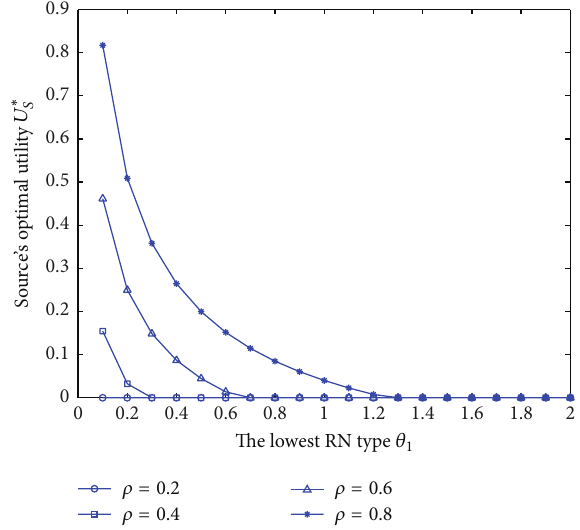
Figure 6: Source’s optimal utility 𝑈 ∗ 𝑆 versus the lowest RN type 𝜃 1 for fixed 𝑁 1 = 2 and 𝑈 = 0.1